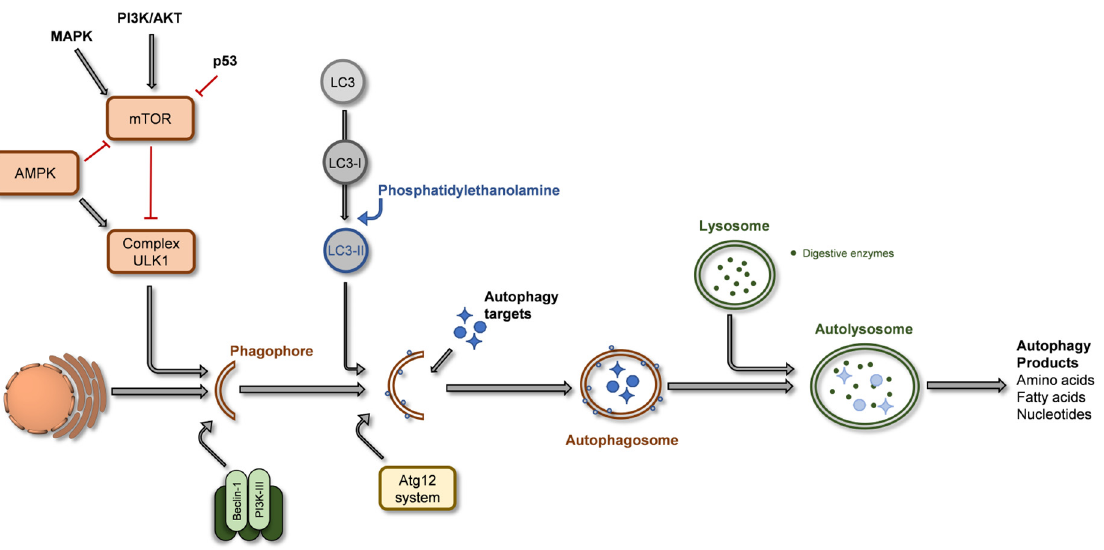
Figure 3. Schematization of main intervenients participating in autophagy signaling pathways. Adapted from [61–64] , and from illustrations courtesy of Cell Signaling Technology, Inc. [65] . Red arrows mean inhibition; grey arrows mean induction. Abbreviations: ULK1, Unc-51 like autophagy activating kinase. All other abbreviations are mentioned in the text.